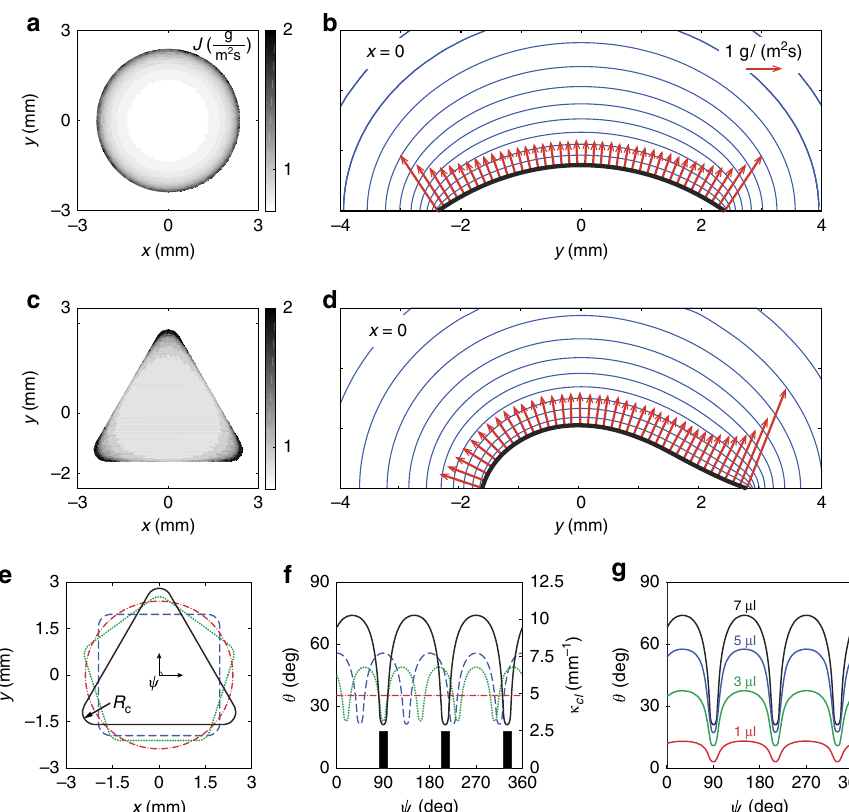
Figure 2 | Simulated evaporation flux distribution and drop geometry. Evaporation flux J distribution in a 7 m l drop with ( a , b ) circular and ( c , d ) triangular contact area, and P ¼ 15mm for the ethanol drops described in Fig. 1. ( e ) Prescribed contact-line geometry for the canonical shapes with P ¼ 15mm and R c ¼ 0.4mm. ( f ) Corresponding contact-angle y distribution with V ¼ 7 m l along with the local contact-line curvature k cl for the triangular drop (filled bars) in terms of the azimuthal angle c as defined in e . The rest of the k cl maps are not shown for the shake of clarity. ( g ) Contact-angle distribution in the triangular geometry for varying drop volume.